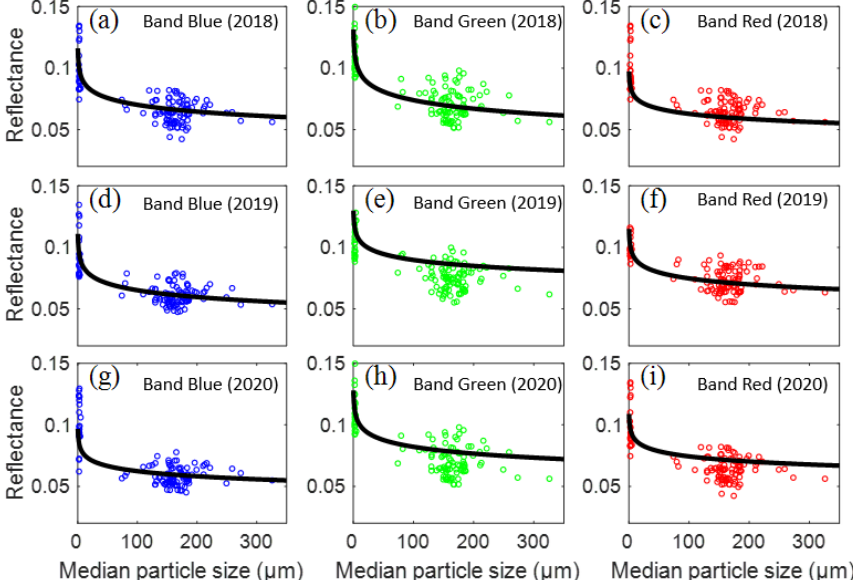
Figure 6. Scatterplots for R b regressions in each visible band for 2018 ( a – c ), 2019 ( d – f ) and 2020 ( g – i ).